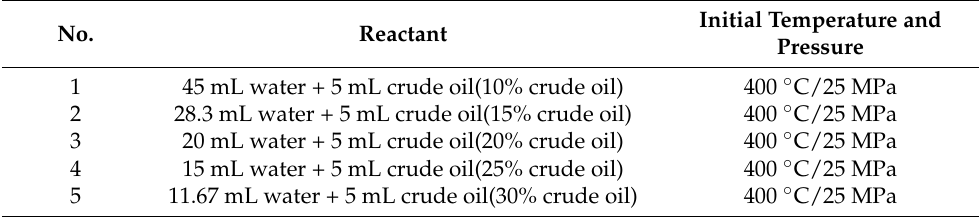
Table 5. Experimental parameters of supercritical water–crude oil reaction to generate supercritical multi-thermal fluid under different oil–water ratios.